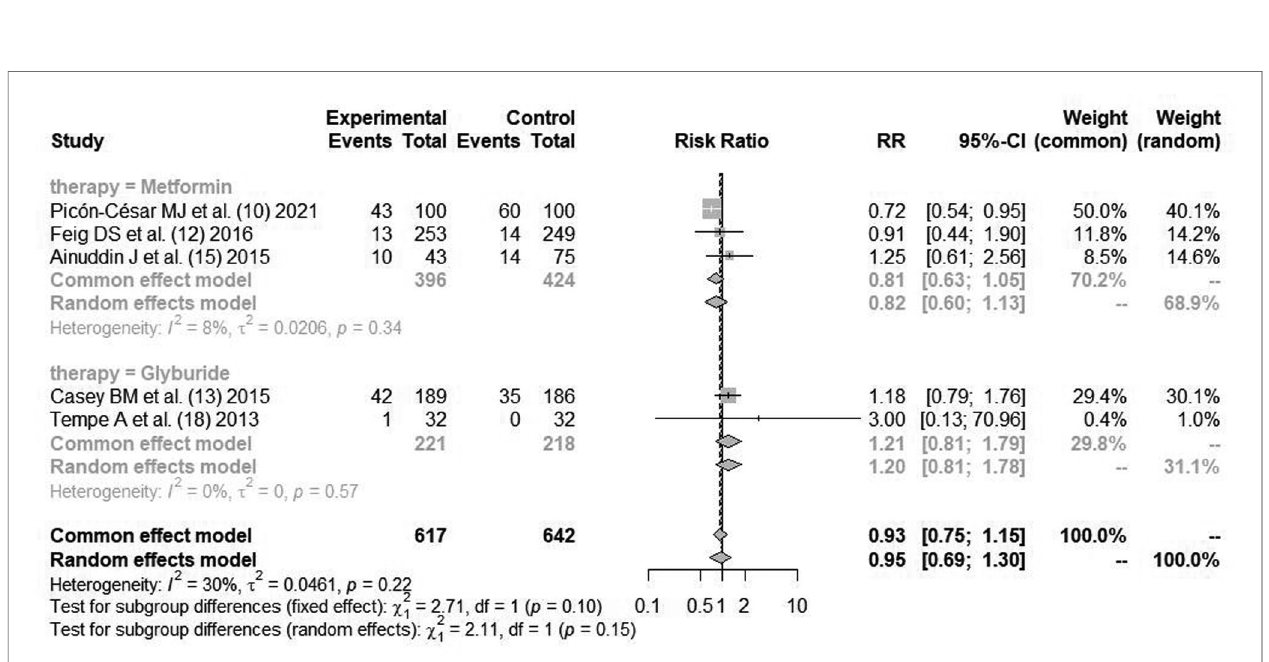
FIGURE 6 | Comparison of maternal abortion rate after blood glucose control during